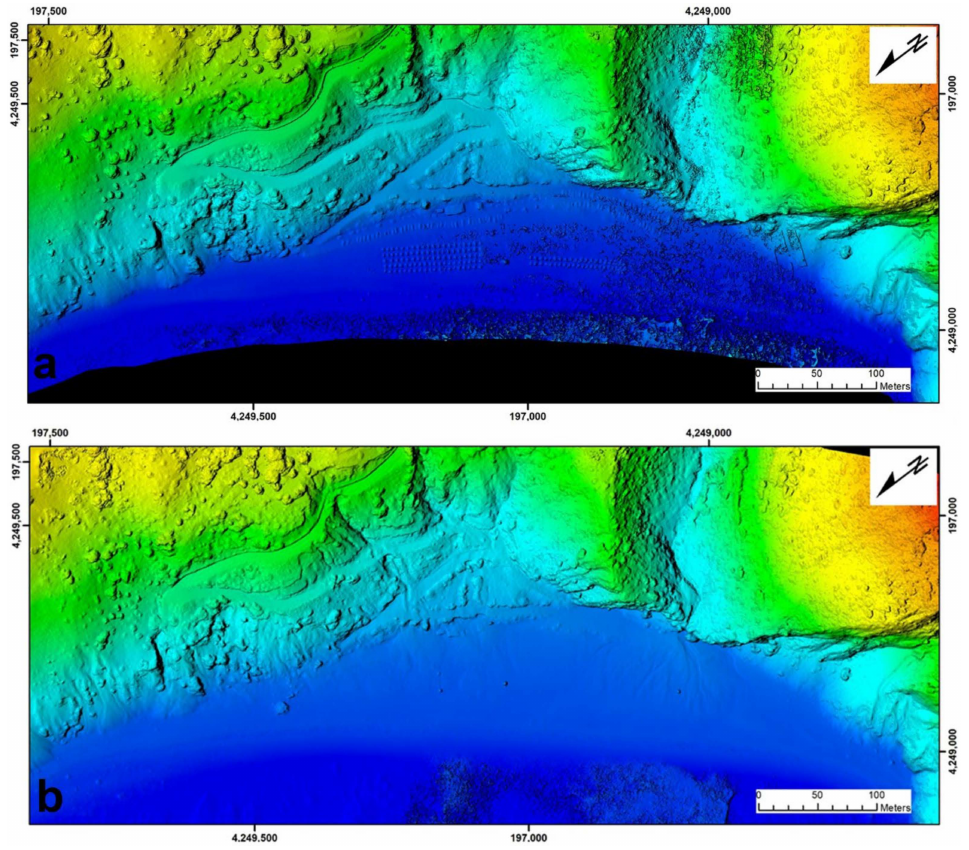
Figure 10. Comparison of digital surface models created from imagery captured ( a ) before and ( b ) after the destructive event.